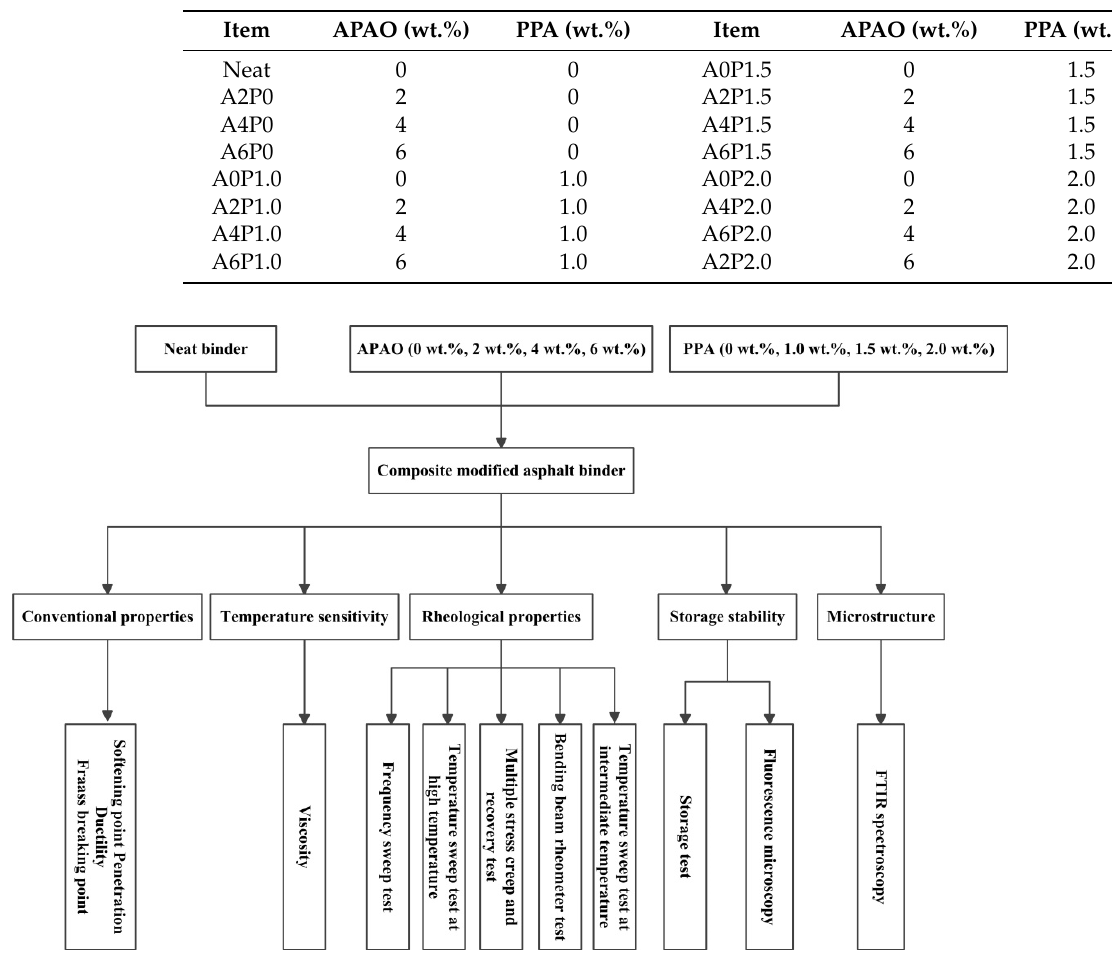
Figure 1. Flowchart of the experimental